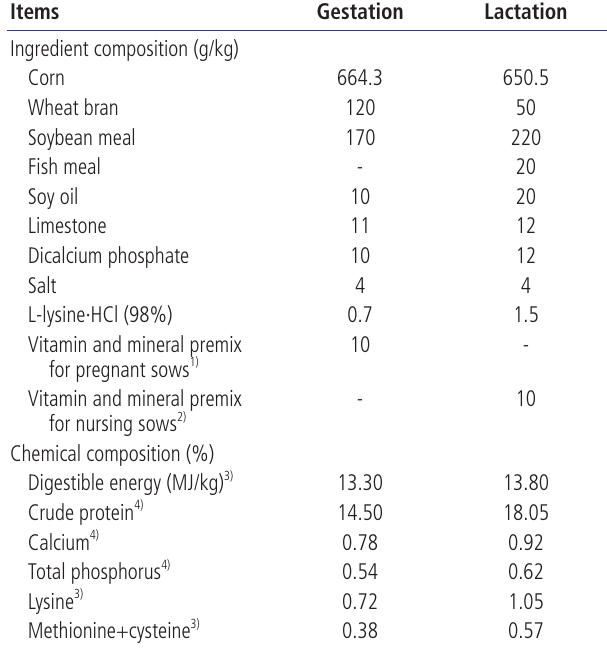
Table 1. Ingredients and chemical composition of the control diets (as-fed basis)